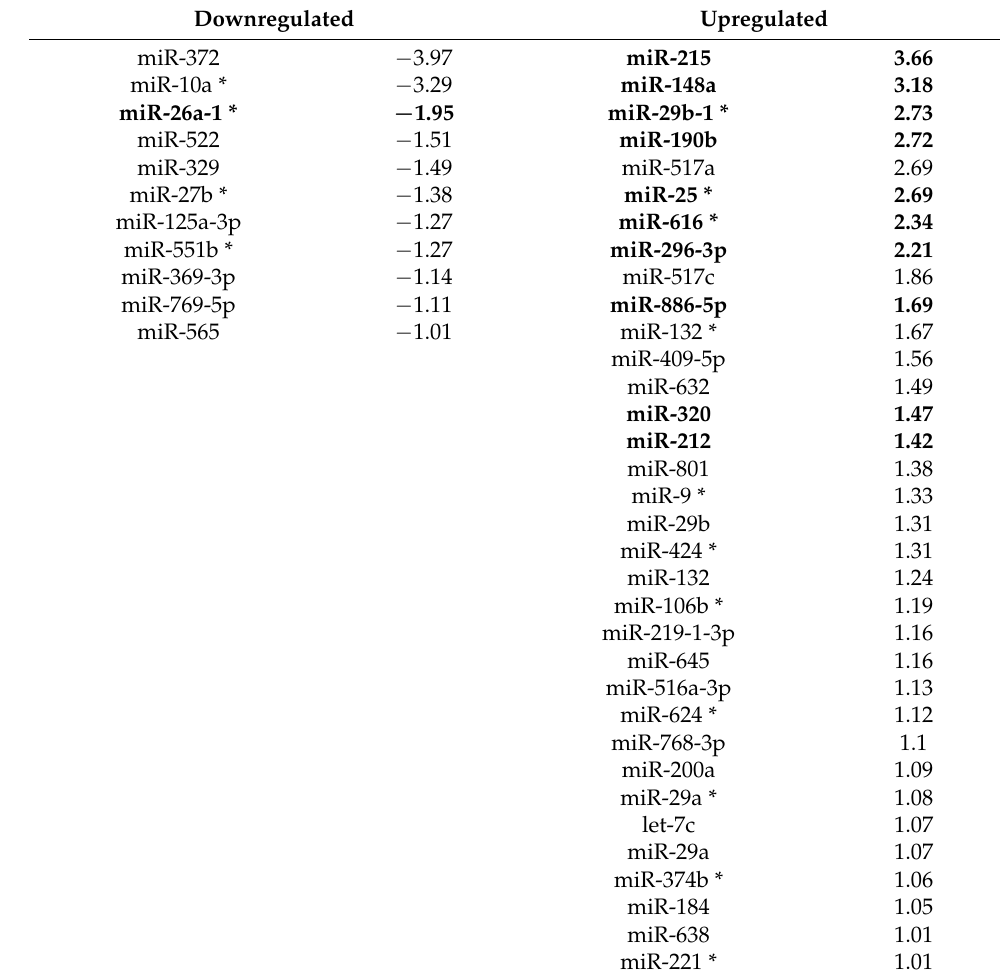
Table 1. RQ (log base 2) of miRNAs in γ T3-treated HeLa cells ( n = 2) with respect to control cells ( n = 4). Data are expressed as the mean value. miRNAs appearing as bold type have a p -value threshold of <0.05 according to a Limma test combined with the Bonferroni method for a false discovery rate; * they refer to the specific probe used in the miRNA PCR array.